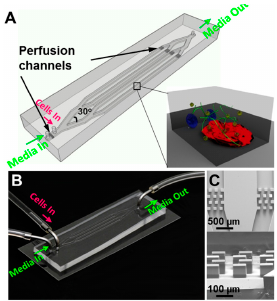
Figure 8. Schematic ( A , B ) and scanning electron microscope (SEM) images ( C ) of the microfluidic platform used to study acute lymphoblastic leukemia [86].